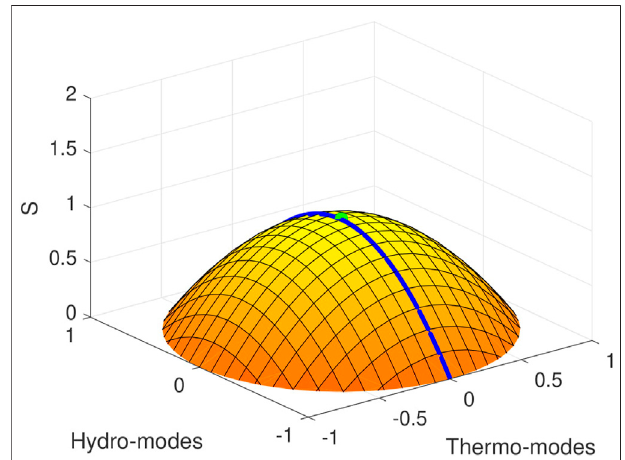
FIGURE3| Thephysical entropy S ofageneric fl uid (arbitrary units). The green absolute maximum point is the equilibrium state, namely the homogeneous perfect fl uid state. The blue line crosses the states accessible by the Navier – Stokes theory. Any deviation from equilibrium reduces the entropy and therefore must decay when the second law is